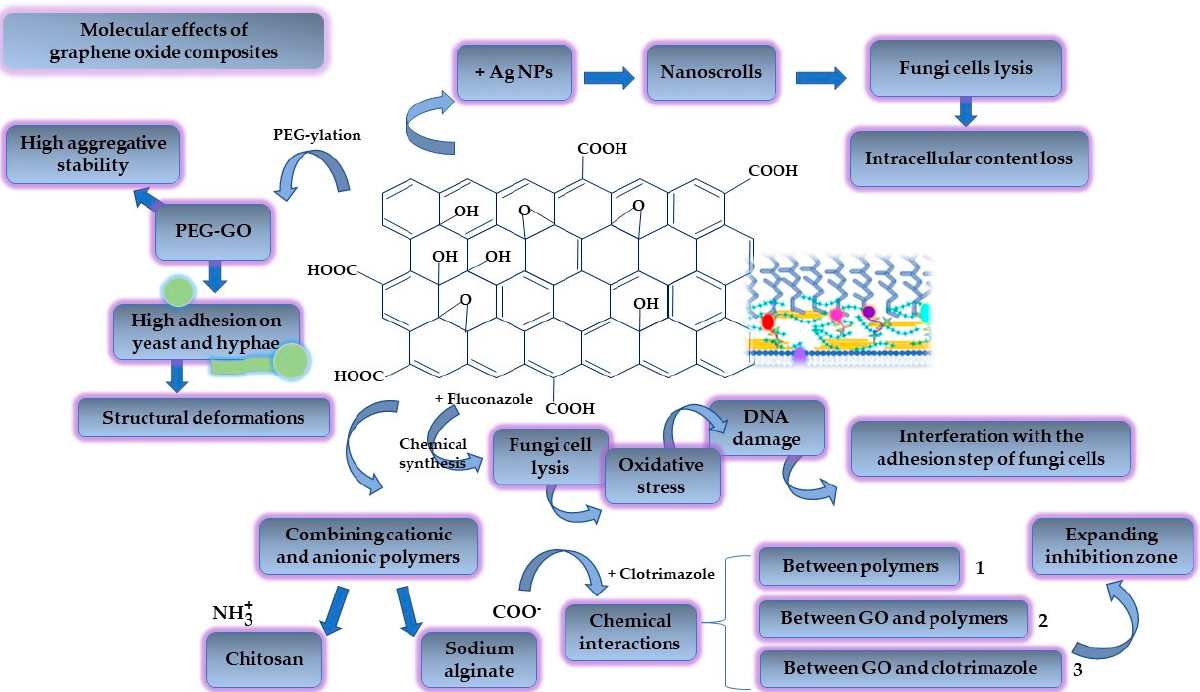
Figure 5. Antifungal activity and molecular effects of graphene oxide biomaterials in C. albicans